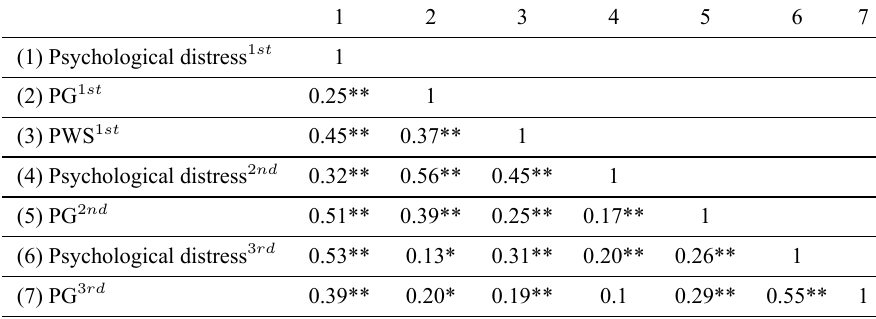
Table 2. Correlation matrix for study variables; n = 283 (Time 1), 277 (Time 2), 274 (Time